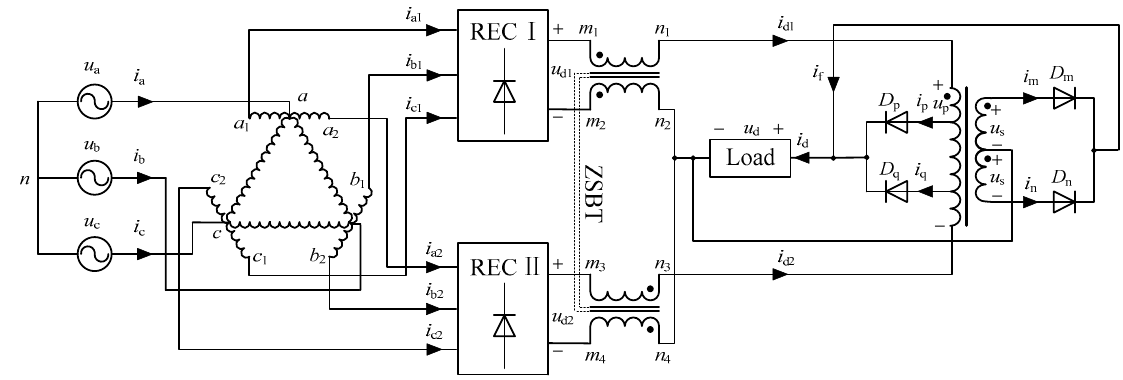
Figure 1. Schematic diagram of the proposed 36-pulse diode rectifier.